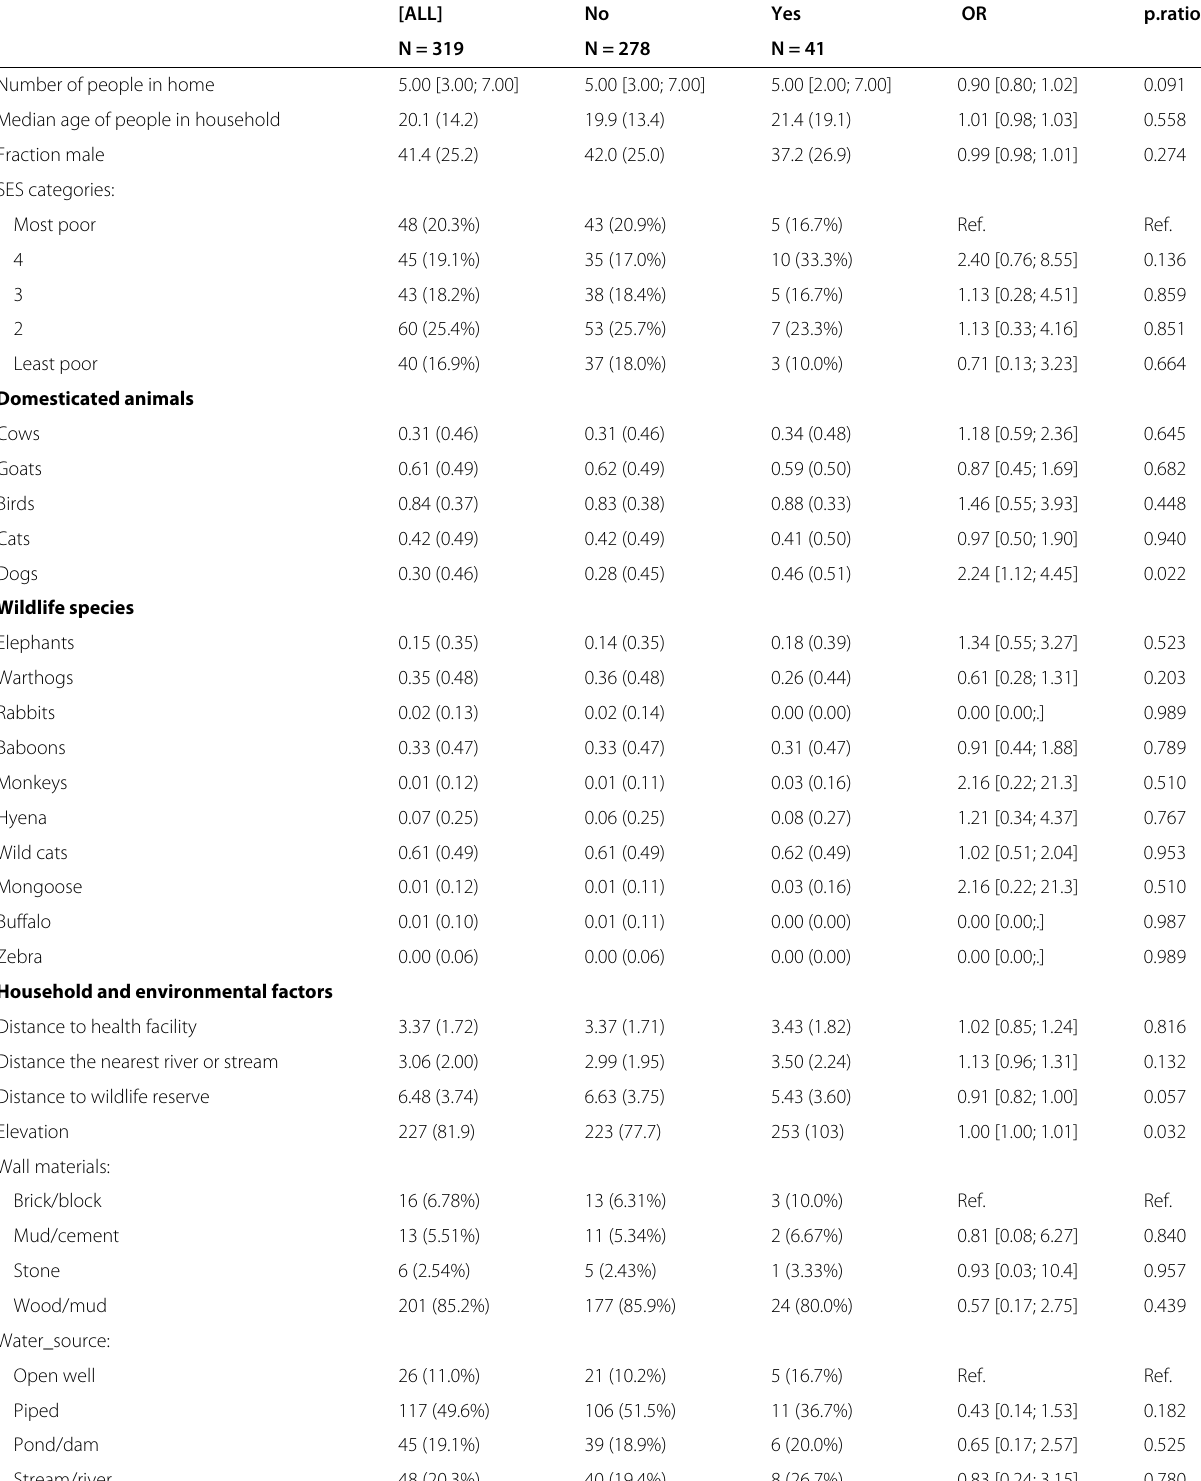
Table 3 Univariate associations of household level human tungiasis (presence/absence of tungiasis case) with household, animal and environmental